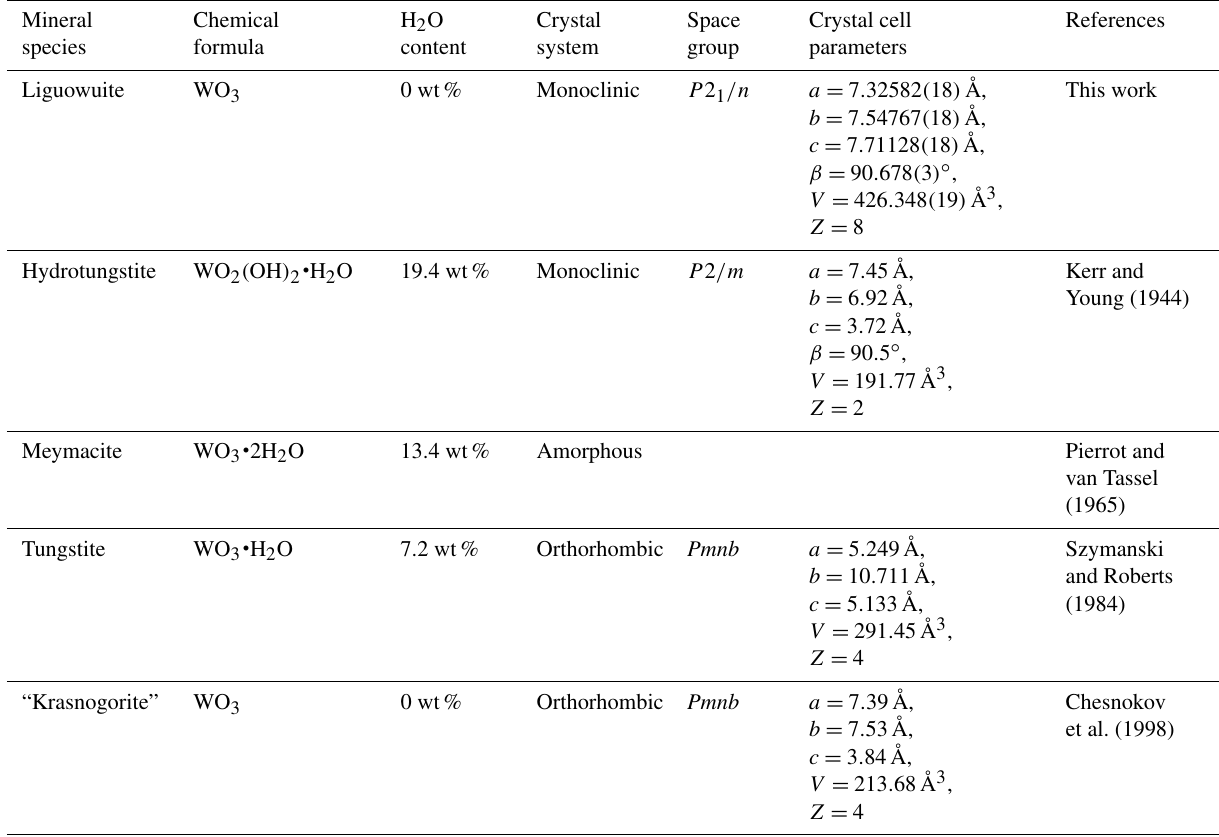
Chemical formula